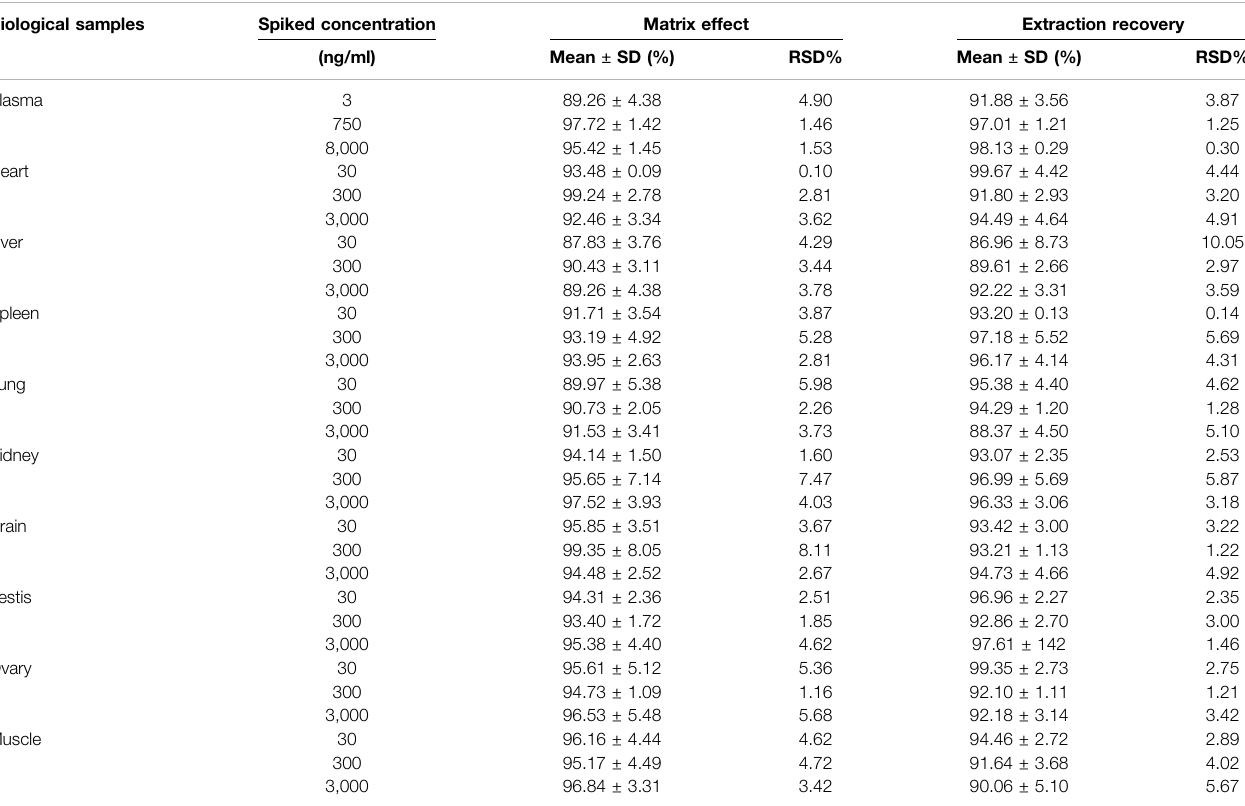
TABLE 2 | Matrix effect and extraction recovery of DF in rat plasma and tissues homogenate ( n (cid:1) 5). Biological